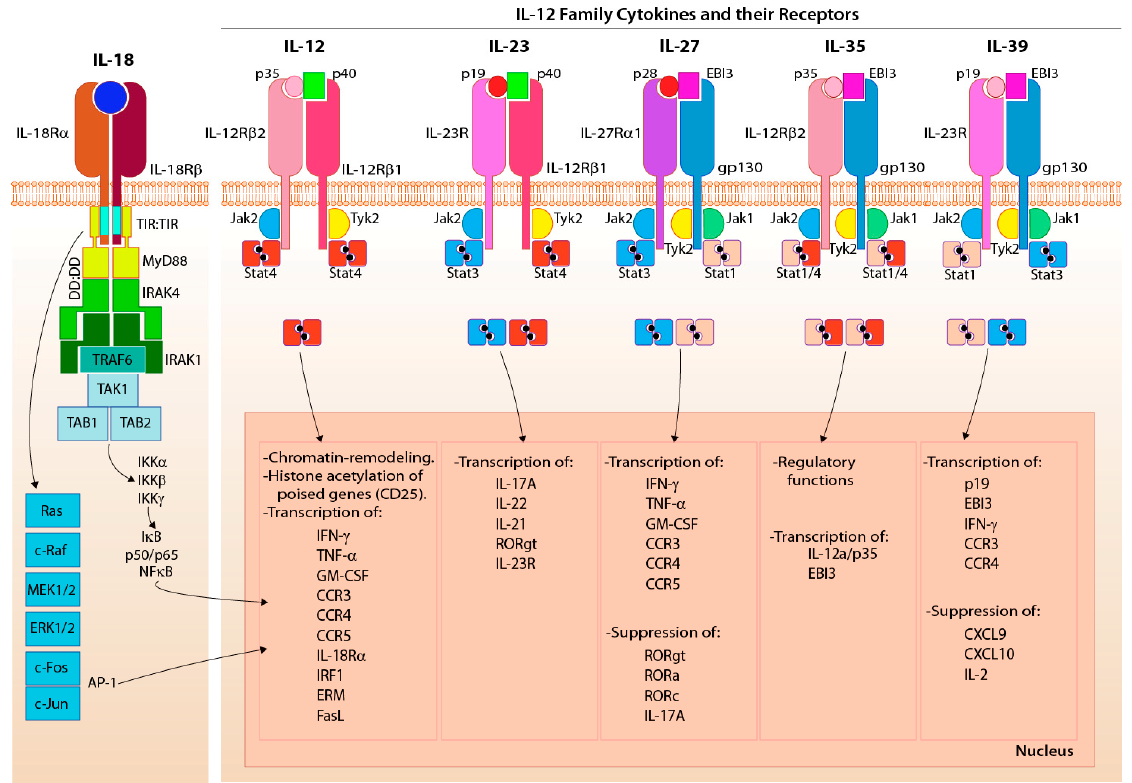
Figure 6. NK cell ‘third signal’ occurs via IL-12 family cytokines and their receptors. Schematic of downstream signaling of the IL-12 family cytokines with their respective transcriptional outcomes. IL-12 consists of p35 and p40 subunits, that activate the IL-12 receptor leading to JAK2/Tyk2 phosphorylation and phosphorylation of Stat4, which can then dimerize and enter the nucleus. IL-23 is composed of p19 and p40 subunits, which activate the IL-23 receptor leading to phosphorylation of JAK2/Tyk2 and signaling via STAT. IL-27 is composed of p28 and Epstein-Barr Virus-Induced 3 (EBI3) subunits and activates the IL-23 receptor leading to phosphorylation of JAK1/2 and Tyk2 and signaling via STAT. IL-35 is composed of p35 and EBI3 subunits and activates the IL-35 receptor leading to phosphorylation of JAK1/2 and Tyk2 and STAT signaling. IL-39 is composed of p19 and EBI3 and activates the IL-35 receptor leading to STAT signaling. Finally, IL-18R does not belong to the IL-12R family but plays a vital role in activating NK cells when co-stimulated with IL-12. Activation via IL-18R leads to the MyD88 ‐ dependent signaling pathway.